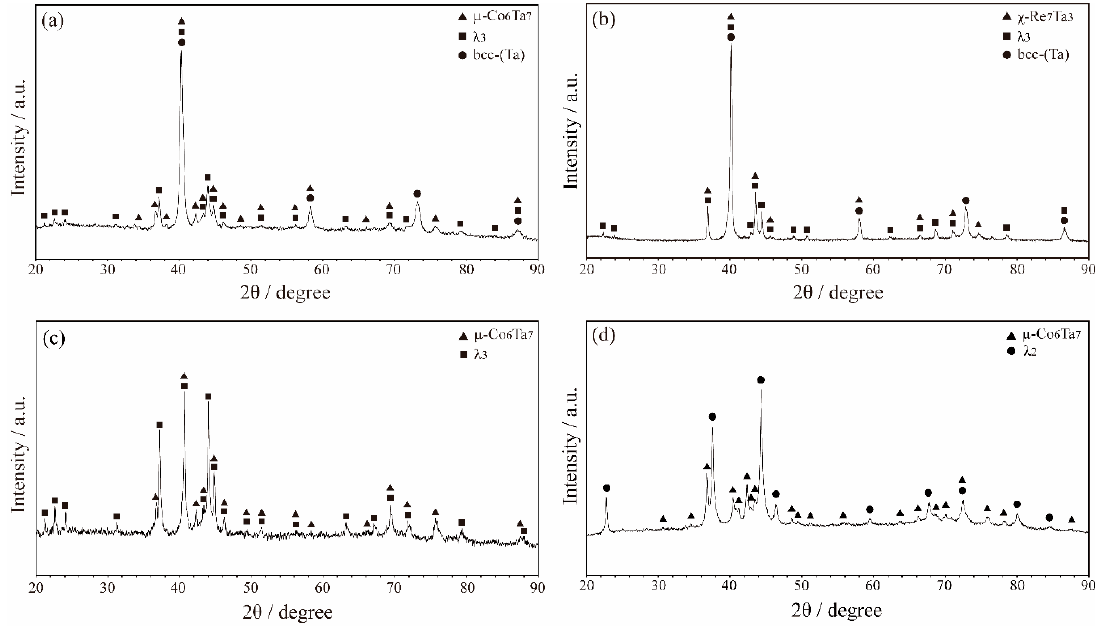
31 Re 35 Ta 34 alloy annealed at 1300 °C for 25 days; ( d ) the Co 45 Re 30 Ta 25 alloy annealed